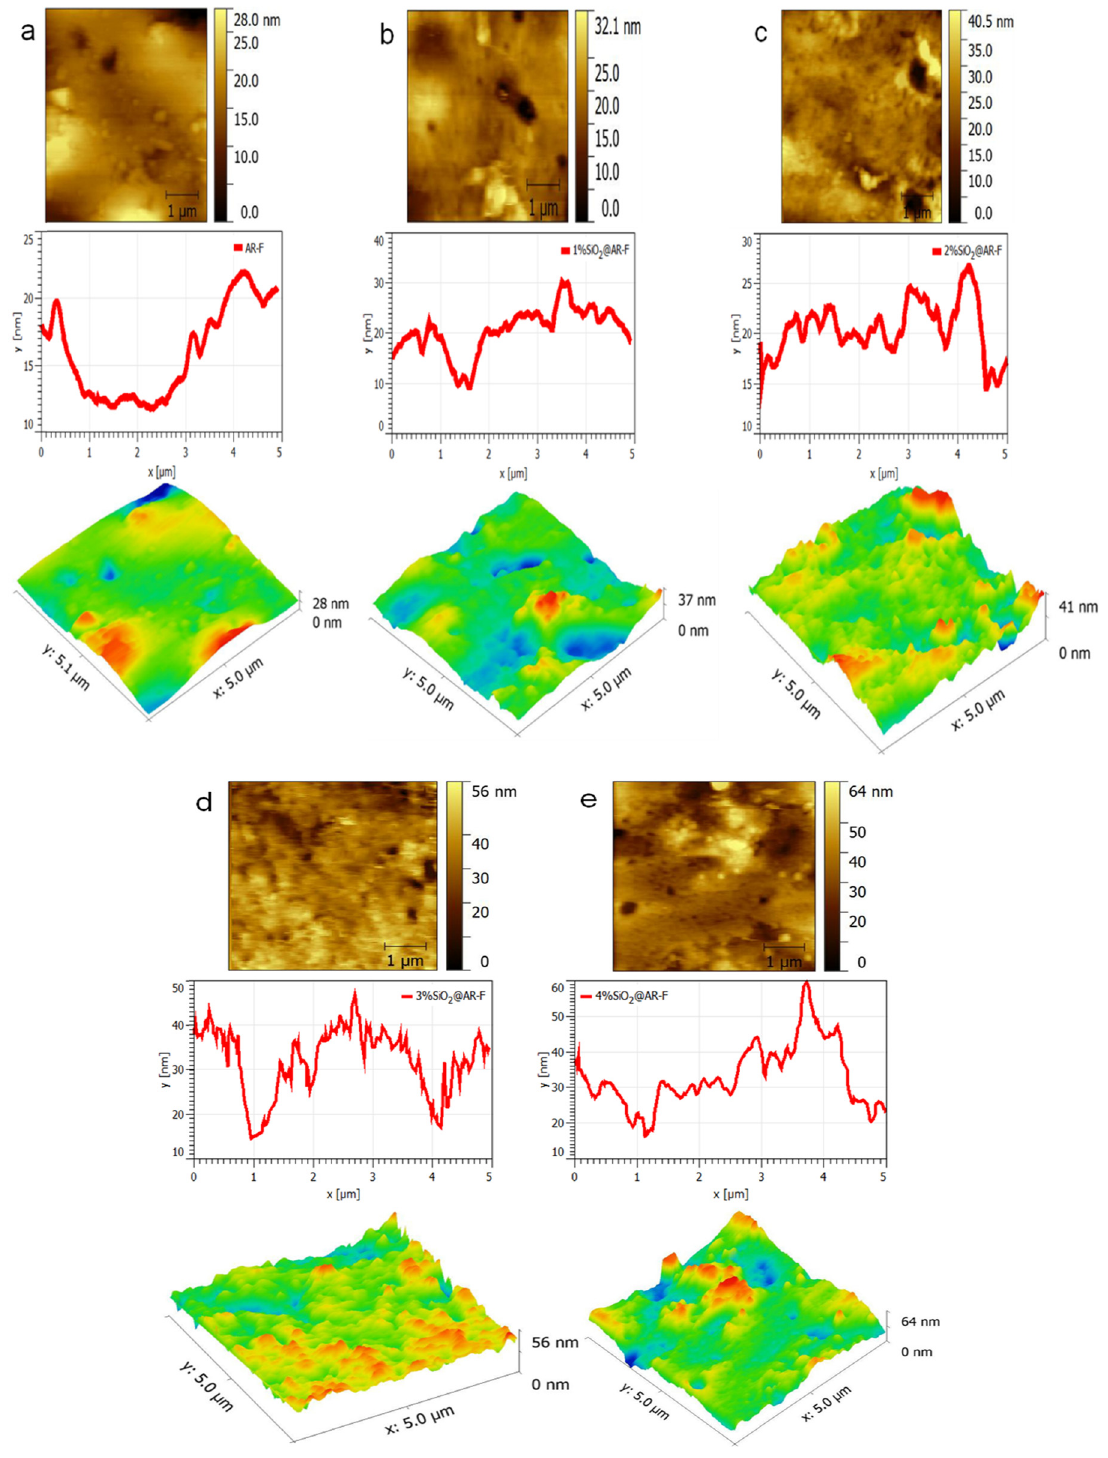
Figure 7: AFM diagrams, surface height diagrams, and 3D diagrams of di ff erent SiO 2 content: ( a ) 0% SiO 2 , ( b ) 1% SiO 2 , ( c ) 2% SiO 2 , ( d ) 3% SiO ( e ) 4% SiO 2 , and 2